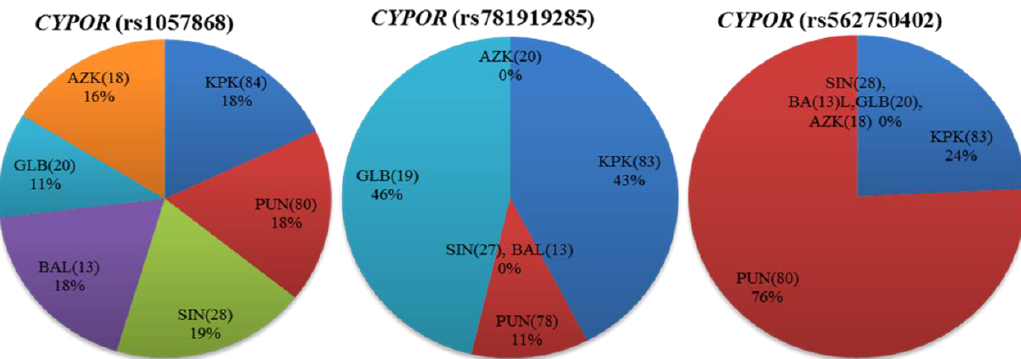
Figure 4. Distribution of the cytochrome P450 oxidoreductase ( CYPOR) missense variants among Pakistani indigenous populations. Percentage allele frequency distributions of CYPOR (rs1057868, rs781919285 and rs562750402) are shown as pie charts for different regions of Pakistan. Numbers in parentheses indicate the group size.